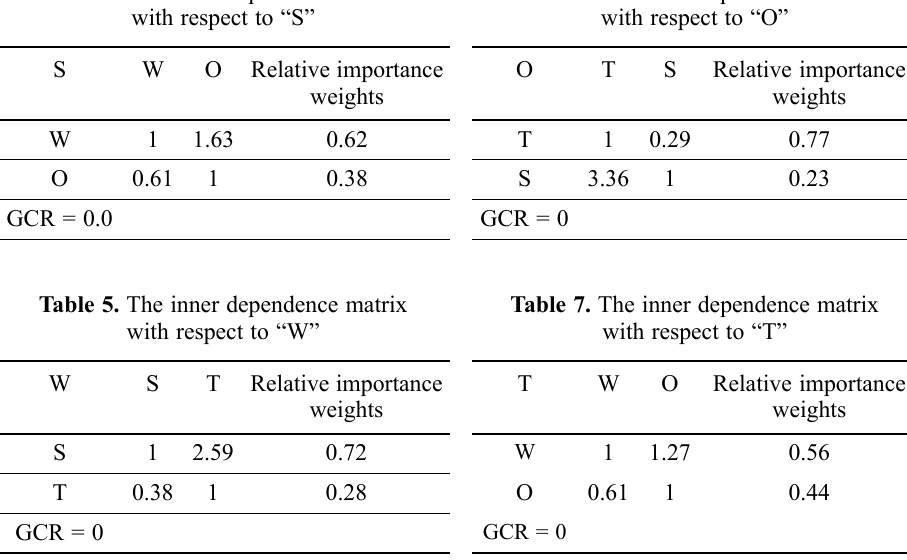
Table 4. The inner dependence matrix Table 6. The inner dependence matrix